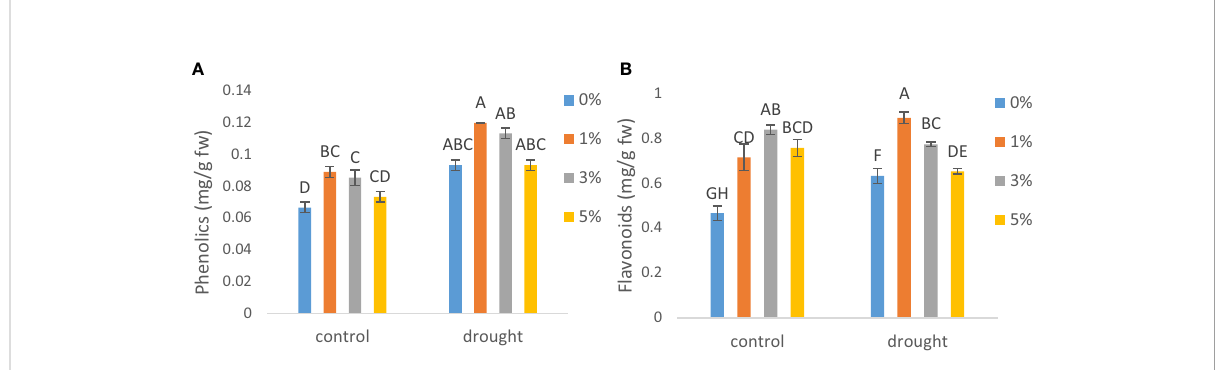
FIGURE 4 The effect of different concentrations of application of nano-nutrients solution on (A) phenolics and (B) fl avonoids in leaves of tomato (Solanum lycopersicum) under drought. Mean values are the average of three replicates. The upper-case alphabetic letters indicate signi fi cant differences (P ≤ 0.05) among treatments using Tukey's